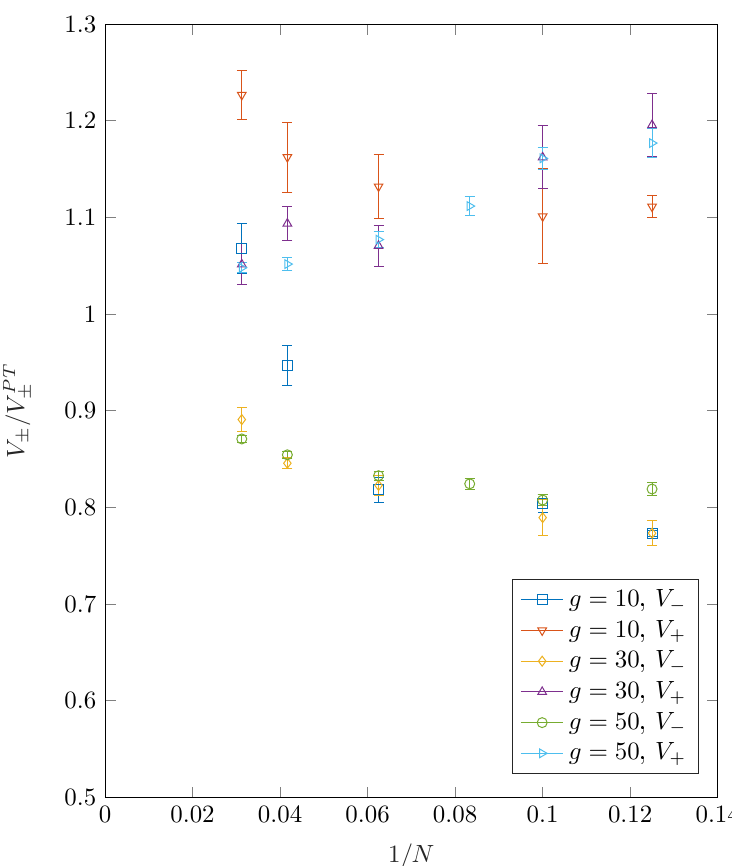
Figure 6 . The ratio of the exponential decays obtained from the MC measurements (via the (cid:12)t (4.36)) and and the PT prediction (4.41) for g = 10 ; 30 ; 50 and various values of N . parameter (cid:22) = 0 : 01. There appear to be no (statistical) correlation between the sign- reweighting W s and the observables, nor between W s and the (cid:22) -reweighting W (cid:22) . However, as discussed in the previous section, small eigenvalues (and thus zero-crossings) are more probable to occur at lower g , which obviously re(cid:13)ects in a more severe sign problem (right diagram, g =